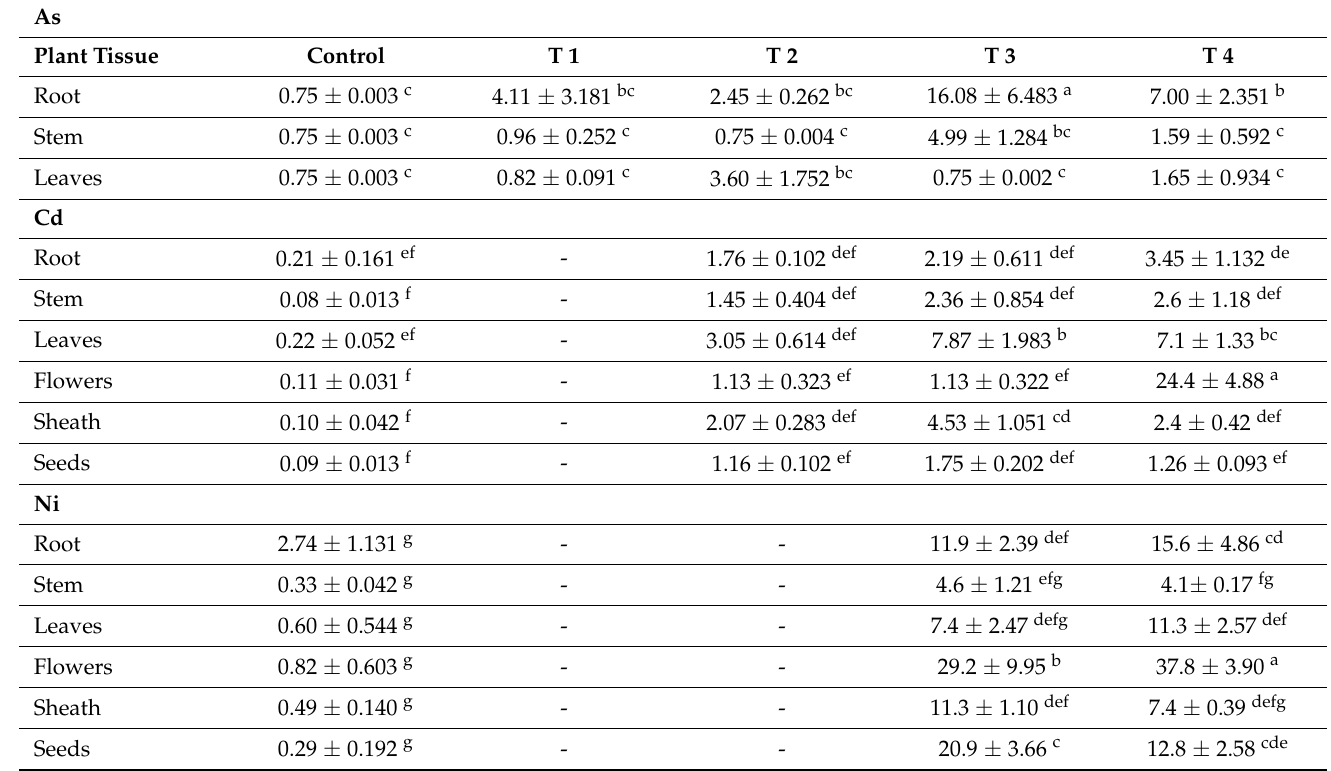
Table 6. Toxic trace metals accumulation in plant tissues of S. alba (mean ± SD, n = 6), mg kg − 1